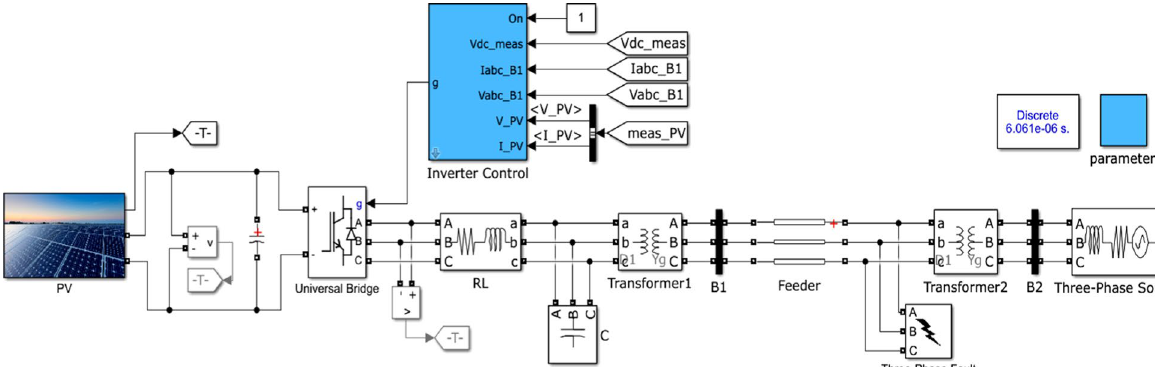
Fig. 11 Simulation model of a grid-connected PV power generation system